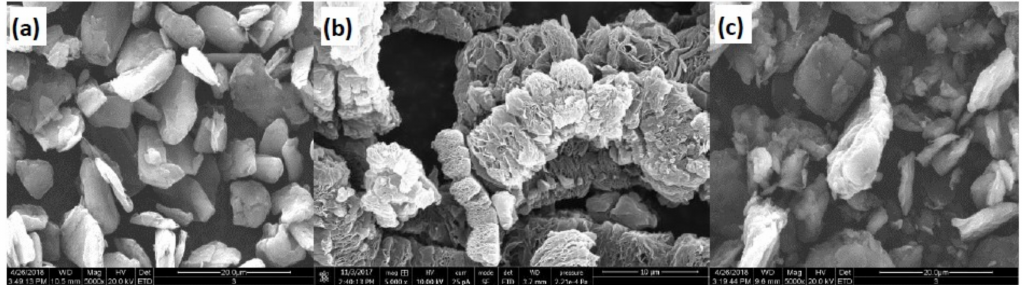
Figure 1. SEM of starting carbonaceous materials with 5000 × zoom including ( a ) D8, ( b ) graphene, and ( c )